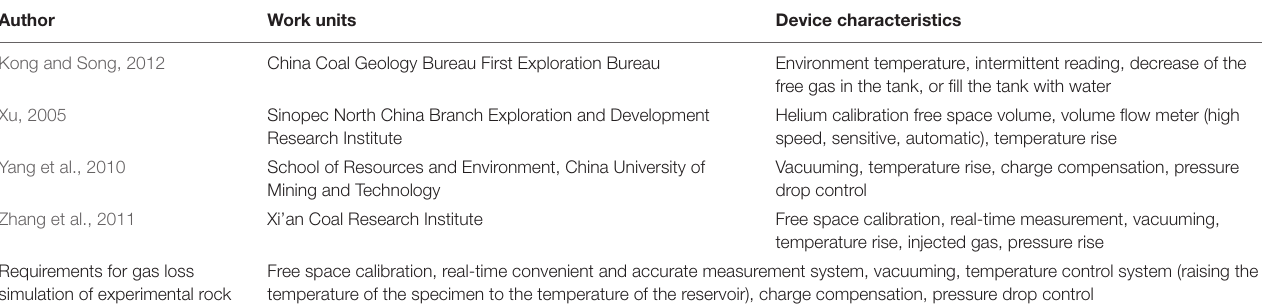
TABLE 6 | Comparison of the characteristics of several typical devices.